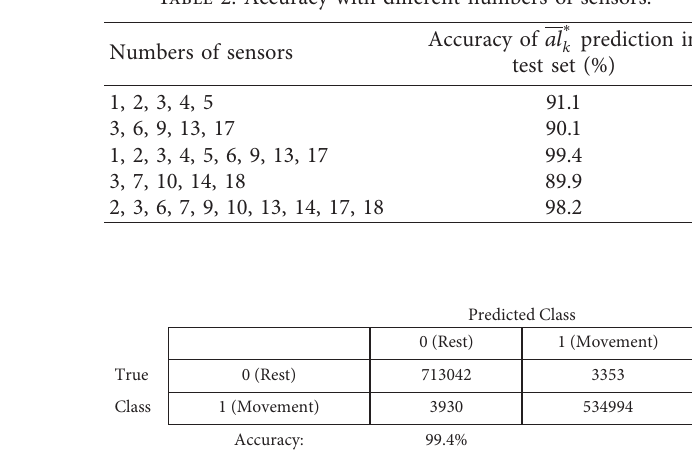
Figure 3: The confusion matrix of Fine